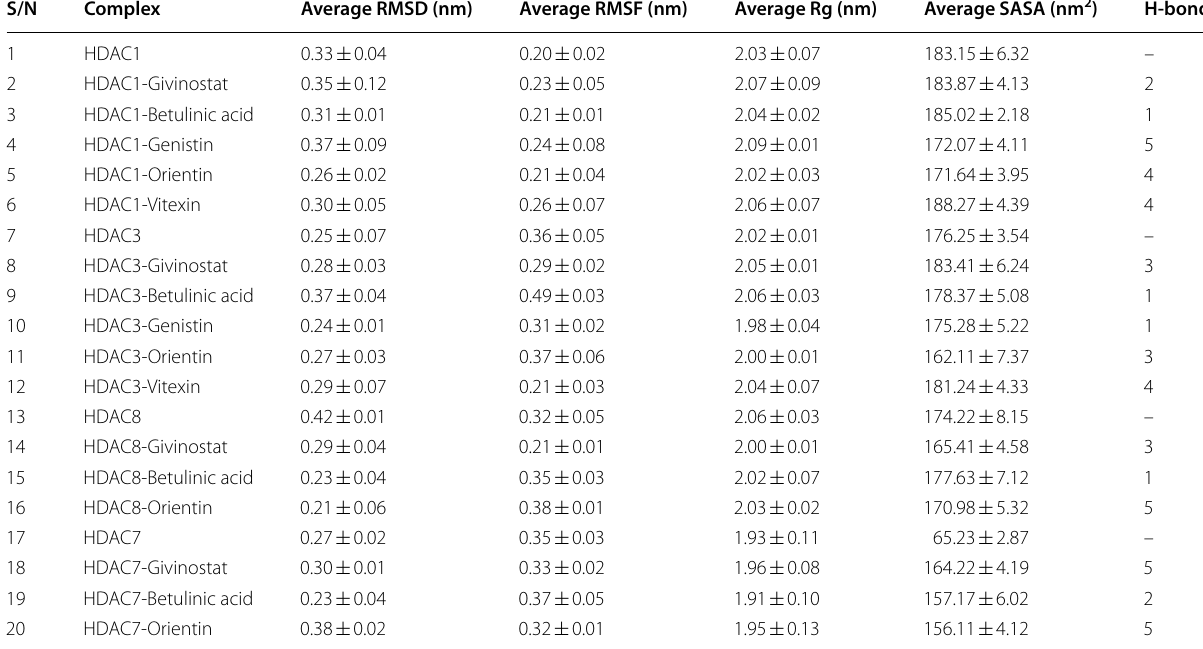
Table 2 The average values of RMSD, RMSF, RG, SASA, H-Bond and Gibbs Energy of HDAC complexes S/N Complex